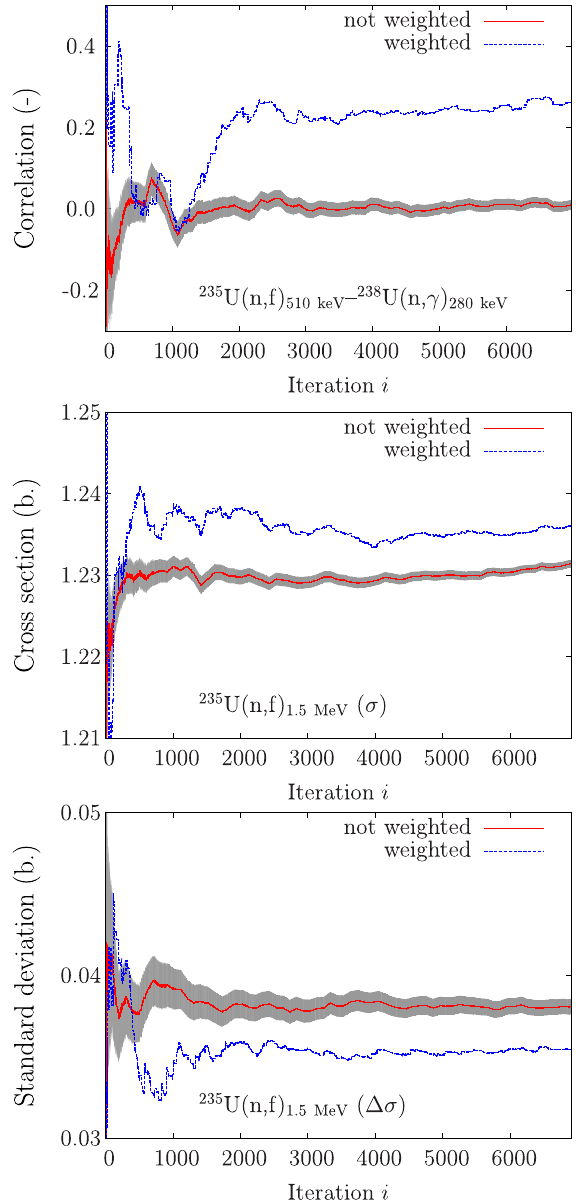
Fig. 2. Example of the running correlation r between 235 U(n,f) at 510 keV and 238 U(n, g ) at 280 keV (top), average cross section (middle) and standard deviation (bottom). The weight comes from the imf7 benchmark. The gray band is the standard error on the correlation factors without weights.